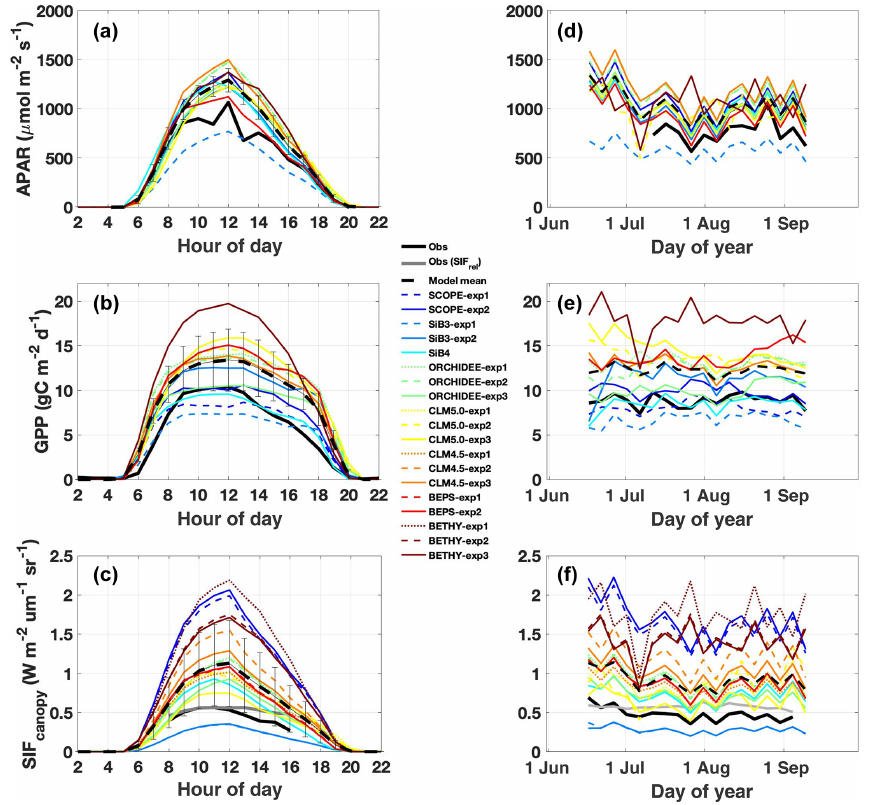
Figure 2. Observed and simulated diurnal and synoptic cycles of APAR, GPP, and SIF. Diurnal cycles (a–c) are averaged over July– August 2017. Synoptic cycles (d–f) are plotted as 5d averages from 15 June to 15 September. Observations are shown in black, with relative SIF (SIF canopy and far-red reflected radiance) included in panels (c) and (f) in grey. The across-model average (dashed black line) represents the average of “best-case” model scenarios (solid lines; SCOPE-exp2, SiB3-exp2, SiB4, ORCHIDEE-exp3, CLM5.0-exp3, CLM4.5-exp3, BEPS-exp2, and BETHY-exp3) with uncertainty bars indicating the across-model 1 σ